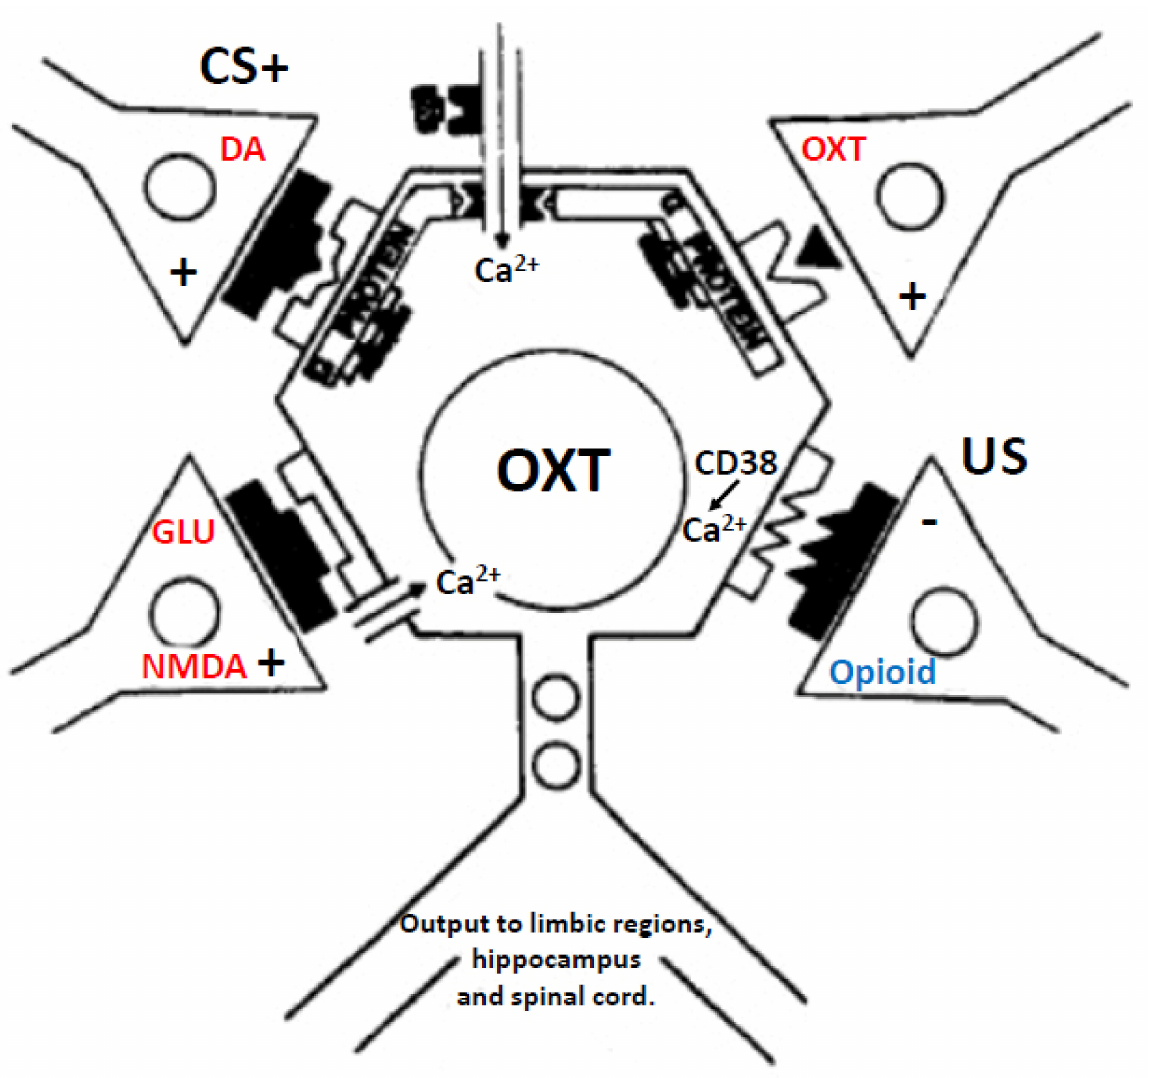
Figure 8. Synaptic inputs to OXT neurons in the PVN and possibly the SON. In this scheme, the CS + signal is carried by augmented incerto-hypothalamic DA transmission driven by sensitized mesolim- bic DA. The US signal is carried by opioid transmission acting on µ opioid receptors. Although this signal inhibits OXT cell membranes, it leads to an augmentation of CD38 gene transcription, mobilization of Ca 2+ , and sensitization of OXT transmission when neurons are stimulated (in this case by DA, but potentially also by OXT and N-methyl D-aspartate [NMDA] glutamate [GLU]